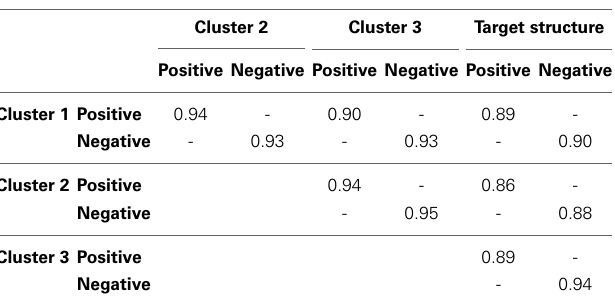
Table 4 | Tucker’s congruence coefficients between the cluster-specific component loadings in Table 3 and the target structure (per component), as well as between the cluster-specific components mutually (per component and per cluster pair), when including all